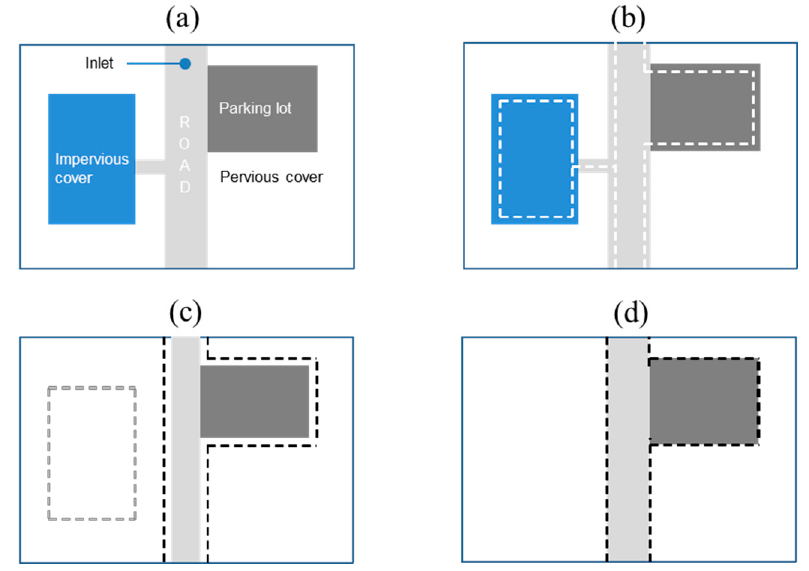
Figure 3. A procedure for determining DCIA using the threshold value and the buffer function in a GIS application.